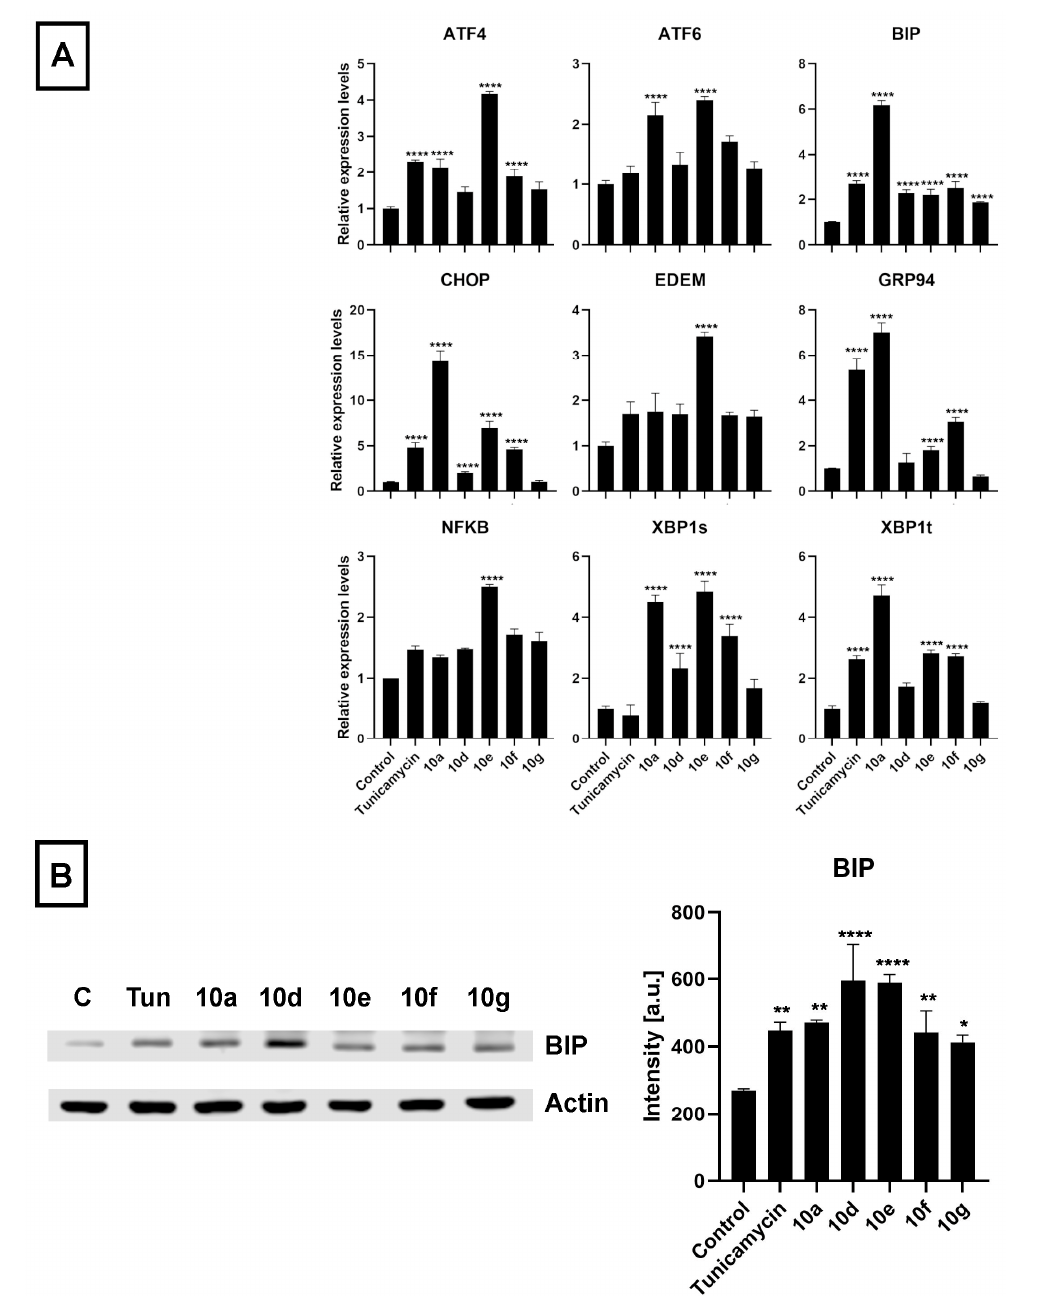
Figure 7. Acetylated androstano-arylpyrimidines induce endoplasmic reticulum stress in multidrug-resistant Colo 320 cells. ( A ) Bar graphs of the relative mRNA levels of various endoplasmic reticulum stress markers in Colo 320 cells treated with steroid derivatives 10a , 10d , 10e , 10f, and 10g (in 20 μ M concentration for 24 h) determined by RT-qPCR measurements and data analysis by the ΔΔ Ct method using GAPDH as the reference gene. For primer sequences and concentrations, please refer to Supplementary Material Table S3. ( B ) Representative Western blot images and densitometric analysis of the ER stress marker protein BIP in Colo 320 cells upon exposure to androstano-ar- ylpyrimidine acetates (treatment with steroid compounds 10a , 10d , 10e , 10f, and 10g in 20 μ M, 24 h) or Tunicamycin (600 nM, 24 h). Equal loading of samples was verified by probing the membrane with an anti-actin antibody. C = Control, Tun = Tunicamycin. In both panels of figure ( A , B ), bar graphs represent mean ± SD values. Fisher’s LSD test, *: p < 0.05, **: p < 0.01, ****: p < 0.0001.